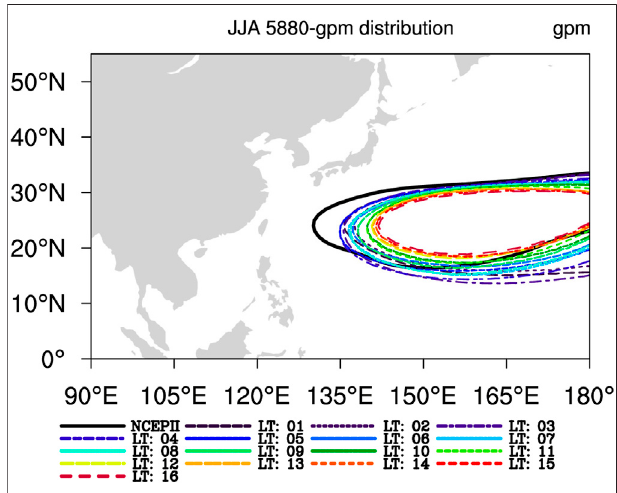
FIGURE 1 | Summer-averaged 5880-gpm lines of the NCEP/DOE Reanalysis (black line) and NCEP-GEFS reforecasts (color lines) at different lead times (LT, unit: